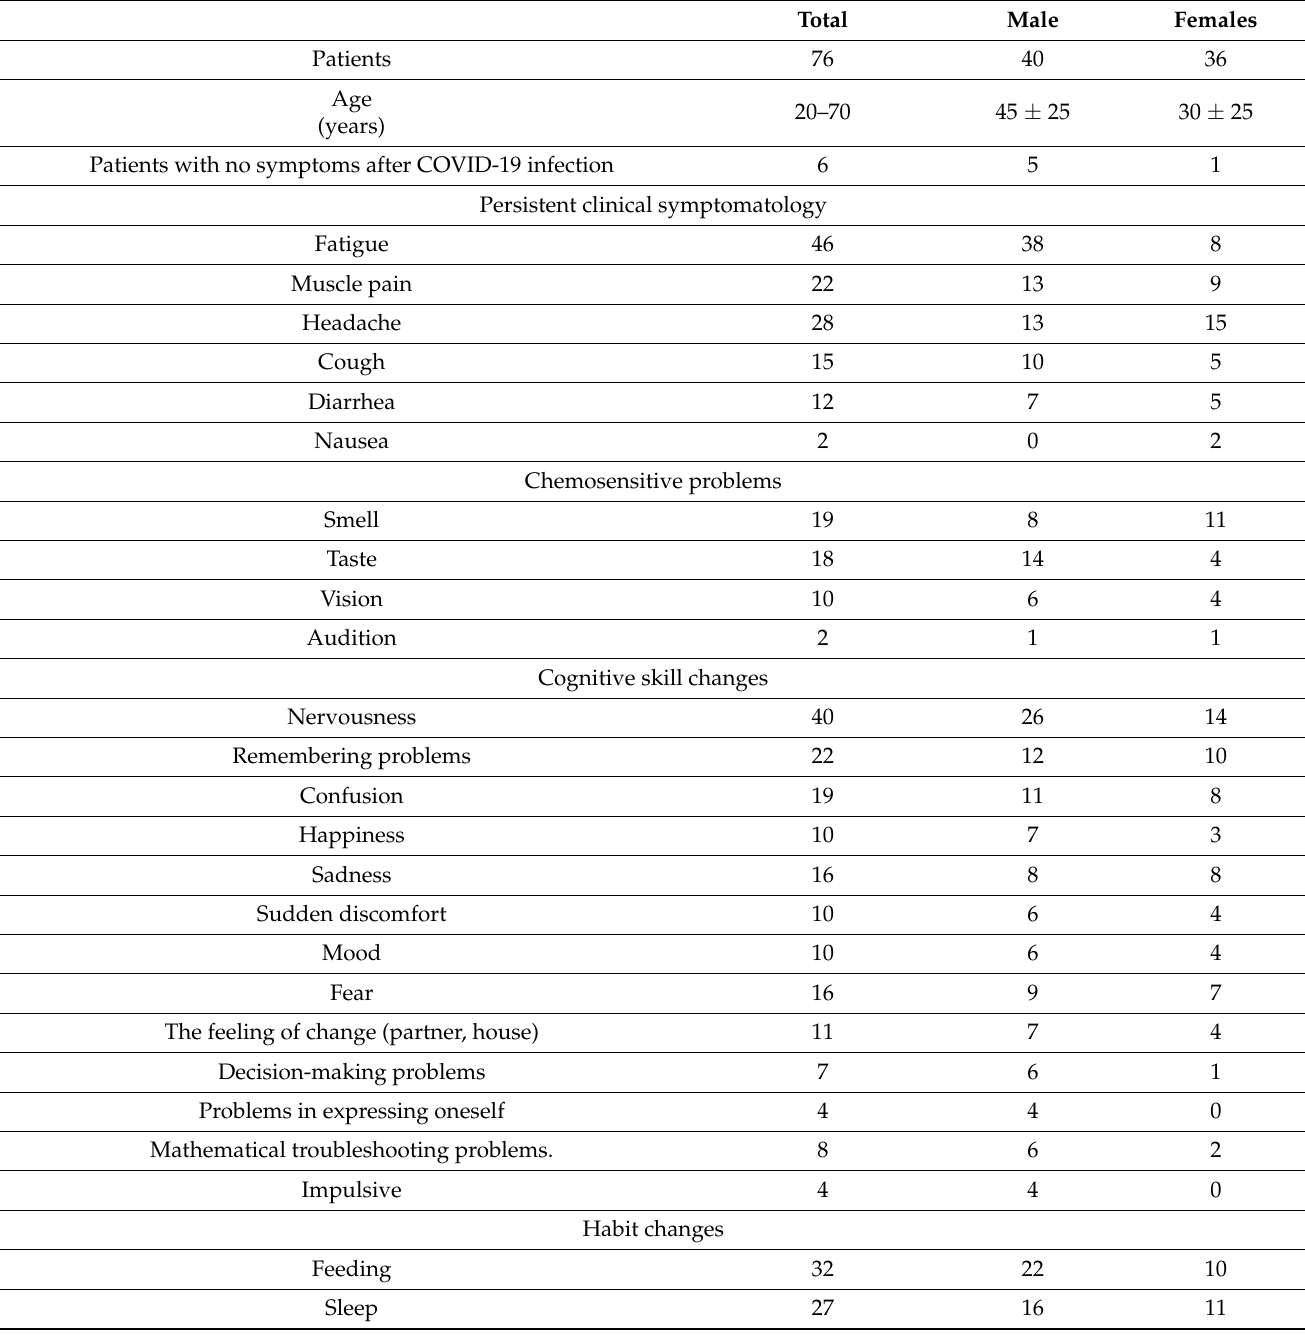
Total Male Females